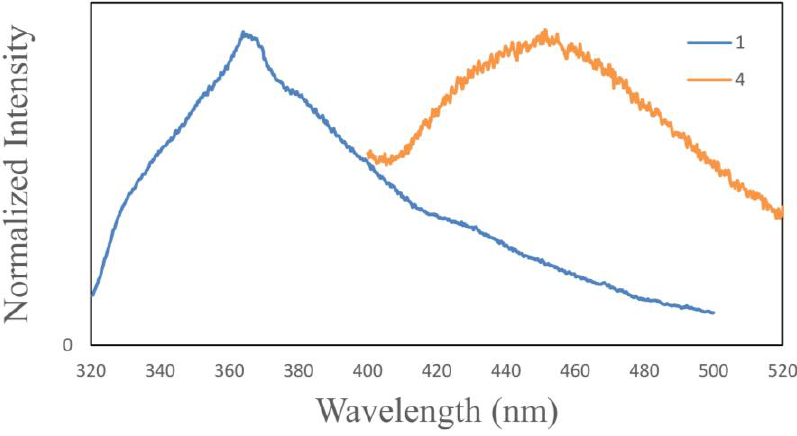
Figure 6. Solid-state emission and excitation spectra of 1 and 4